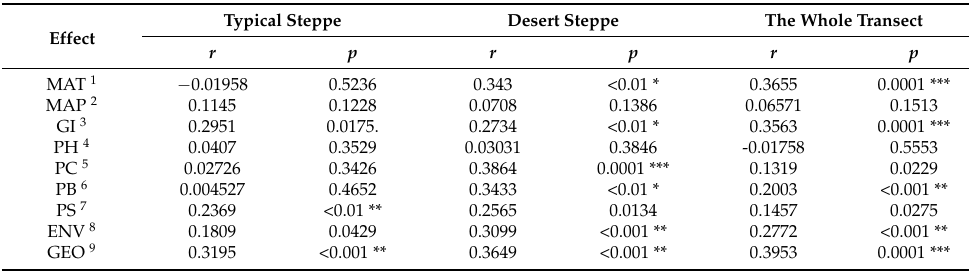
Table 2. Effects of different environmental factors in the Mantel test analysis for each of the two steppe types and the whole transect in EEST.